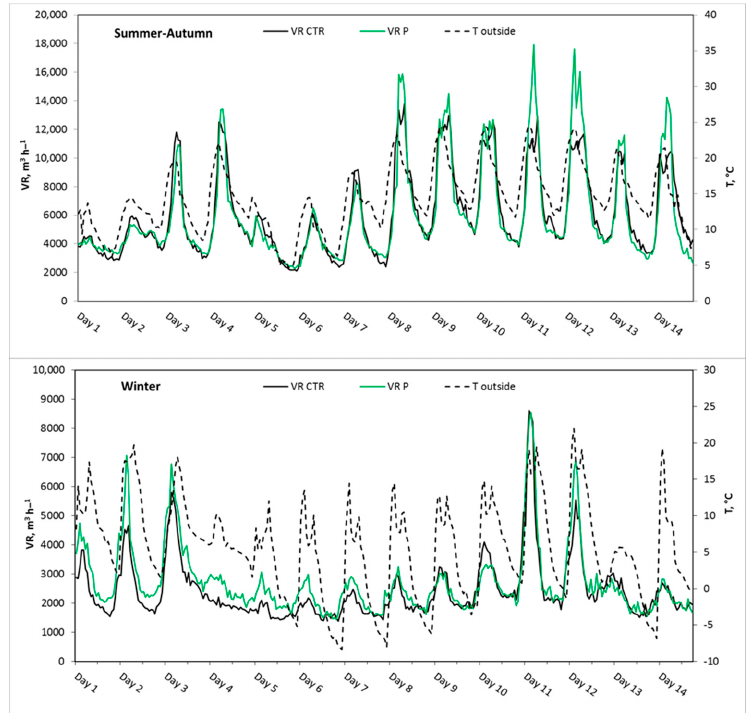
Figure 4. Ventilation rate (VR) in the compartments CTR and P and the outside temperature (T outside) in the two measuring periods (summer–autumn and winter). outside) in the two measuring periods (summer–autumn and